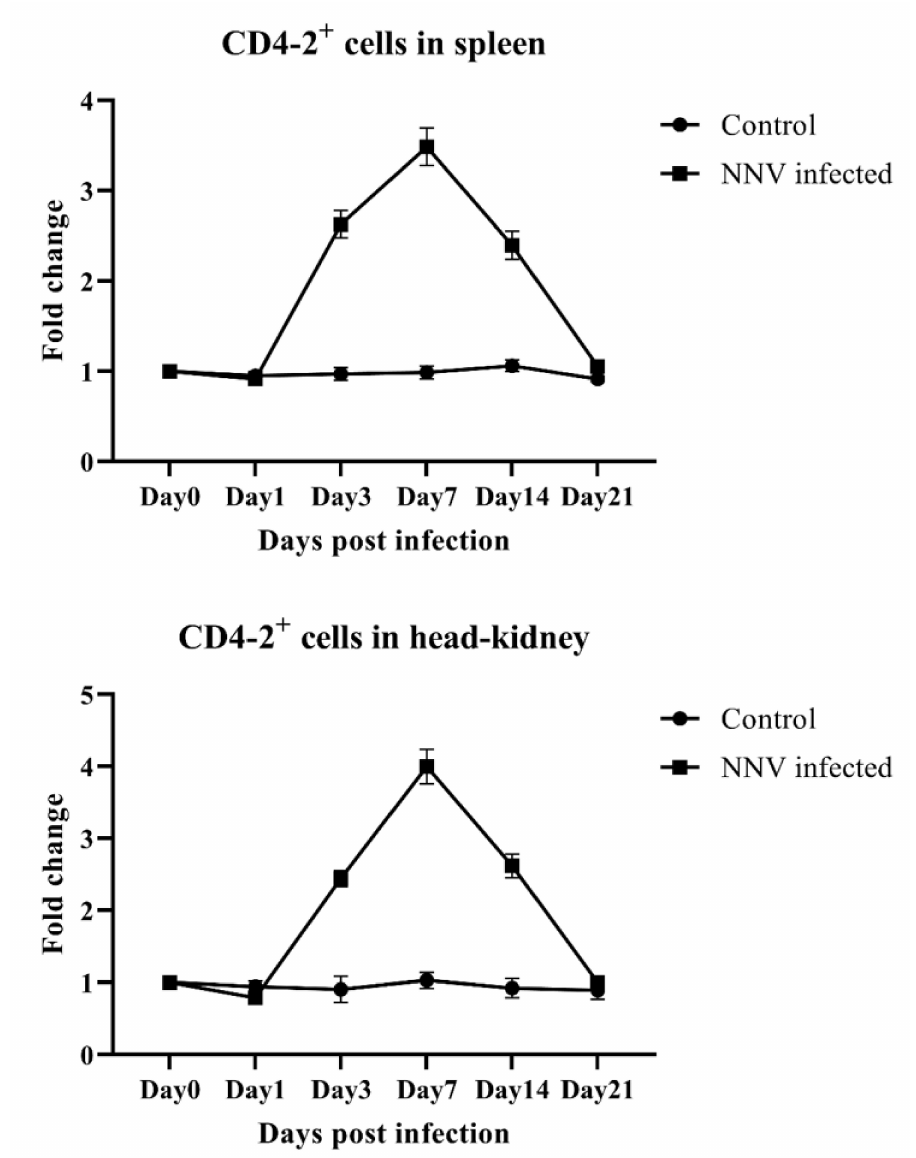
Figure 6. Variations in CD4-2-positive lymphocyte percentage in the spleen and head-kidney after injection with a nervous necrosis virus (NNV). Leukocytes from the spleen and head-kidney were obtained at 0, 1, 3, 7, 14 and 21 days post infection, and incubated with anti-CD4-2 mAb (3C8), followed by FITC-conjugated goat anti-mouse IgG. Data are presented as the mean ± SD of three